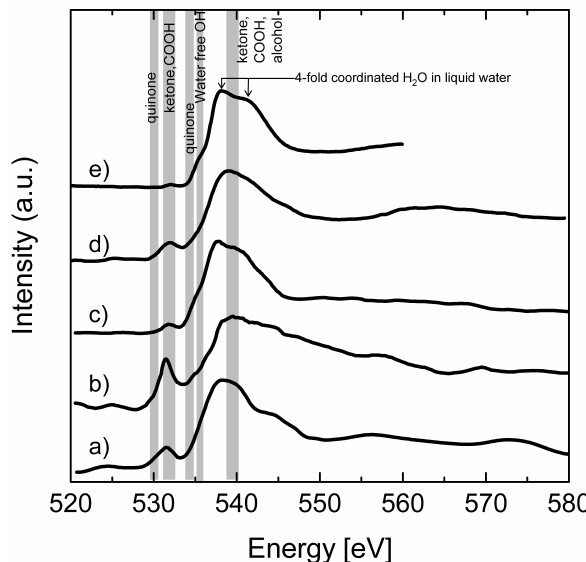
Fig. 8. O K-edge NEXAFS spectra of (a) fresh soot particles from the wood stove measured at 90% RH, (b) aged soot from wood stove at 0% RH, (c) same particles as in (b) at 90% RH, (d) aged soot from the EURO 2 transporter at 90% RH, (e) liquid water taken from Tzvetkov et al. (2008). The spectra are normalized to the high- est absorption